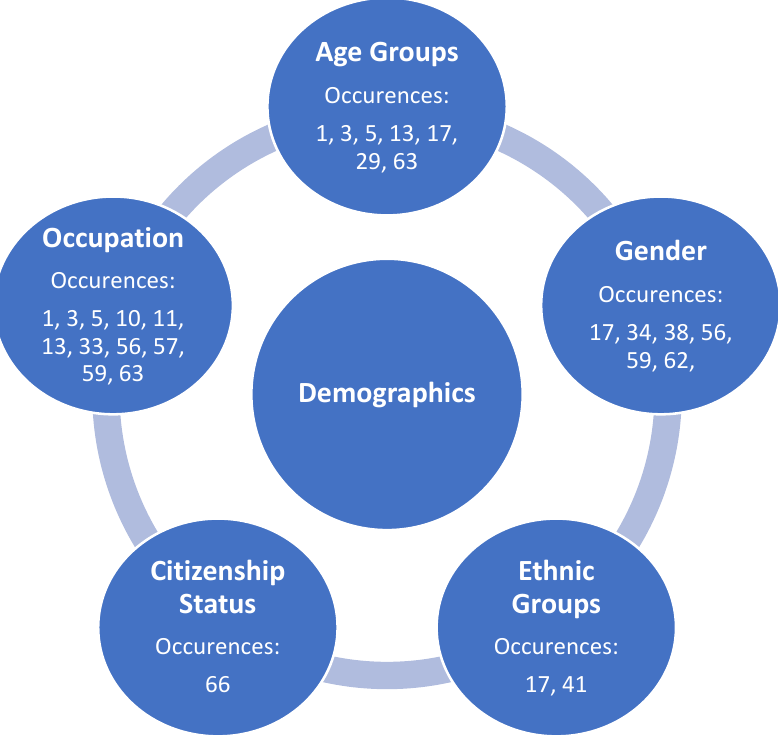
Figure 5. Identified sub-themes (underlying sub-constructs) identified non-protective demographic factors of mental health distress during the COVID-19 pandemic in the United States.